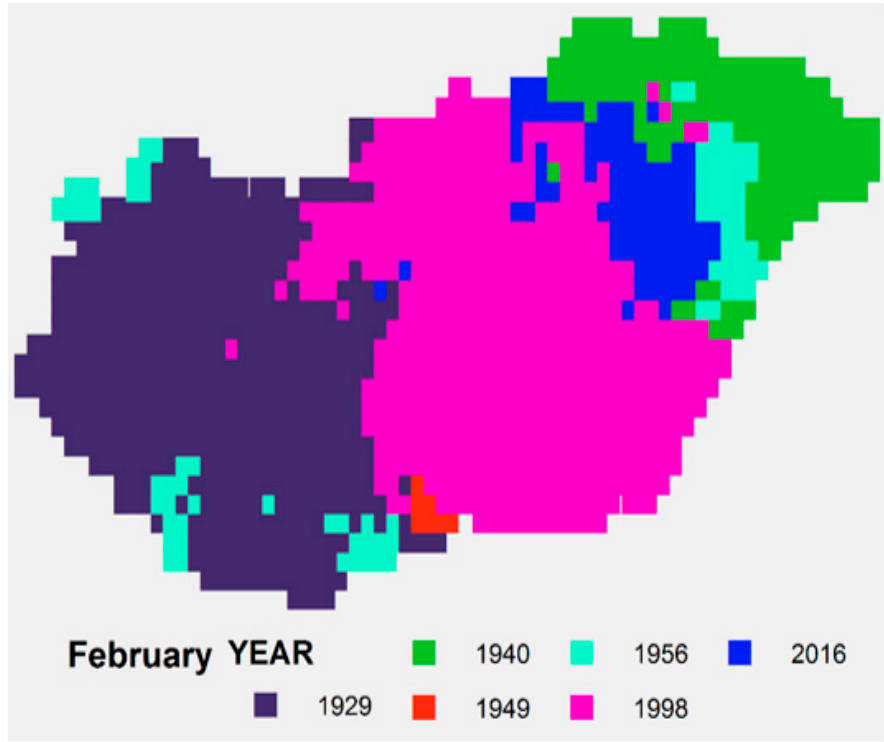
Figure A1. February: Year of maximum SPTI values, 1871–2020.